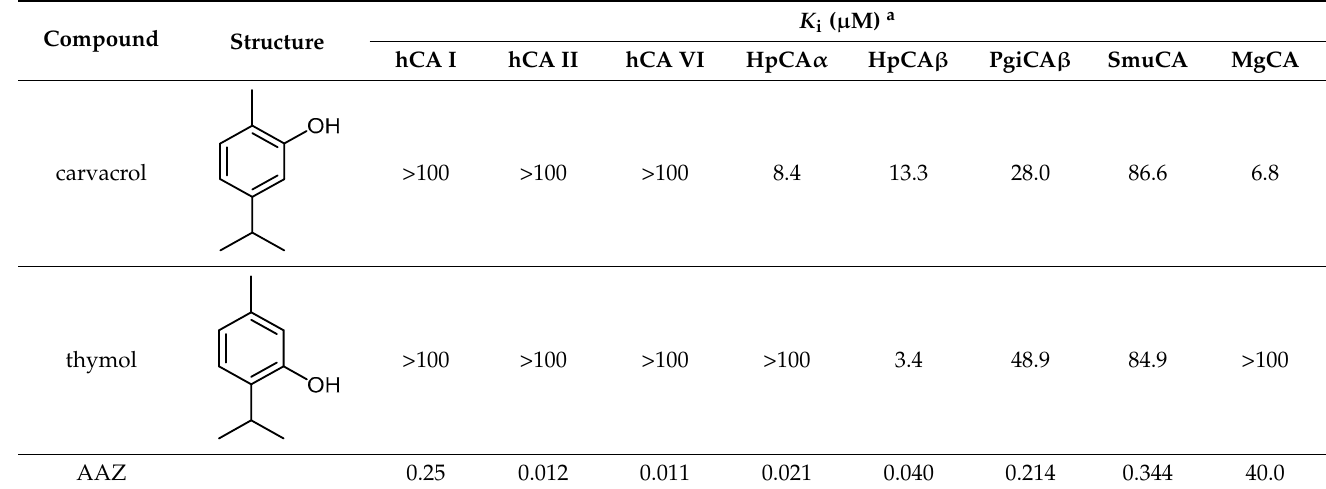
a Mean from three different assays by using a stopped-flow technique, and errors are in the range of ±5–10% of the reported values.